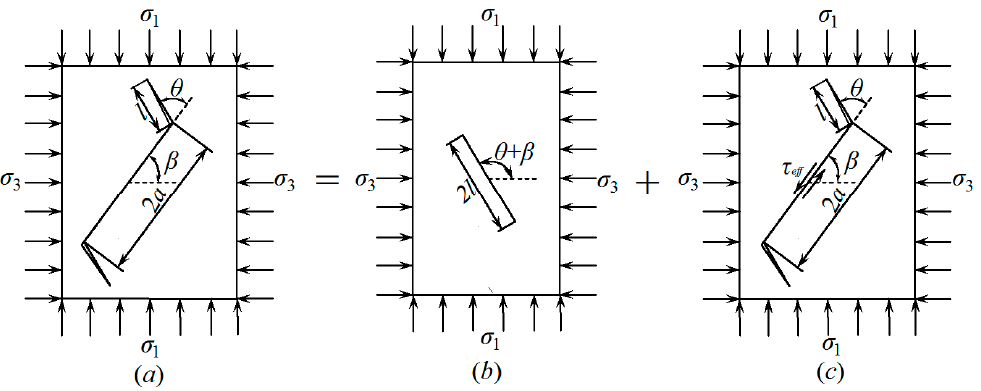
Figure 2. Schematic diagram of the superposition technique used to calculate the K Iwing at wing crack tip subjected to far field stress: ( a ) K Iwing at the wing crack tip; ( b ) K I i sol for the straight wing crack of common length 2 l ; and ( c ) K I infl due to effective shear stress.